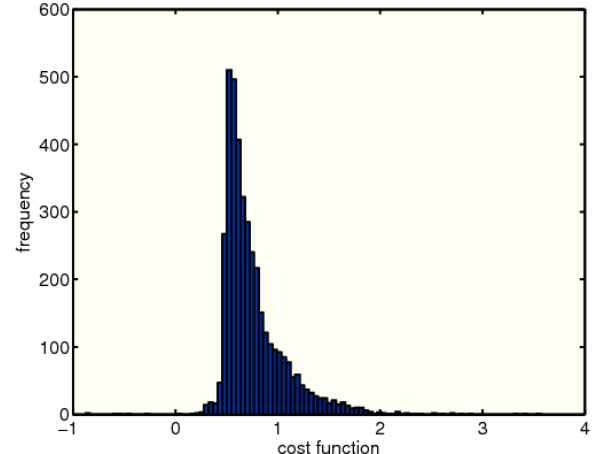
Figure 6: Distribution of the resulting cost function from the Monte Carlo extension of the differential evolution algorithm